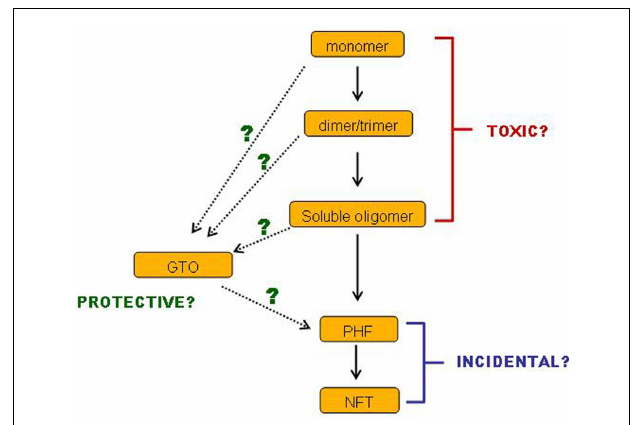
FIGURE 2 | Cartoon of remaining questions .